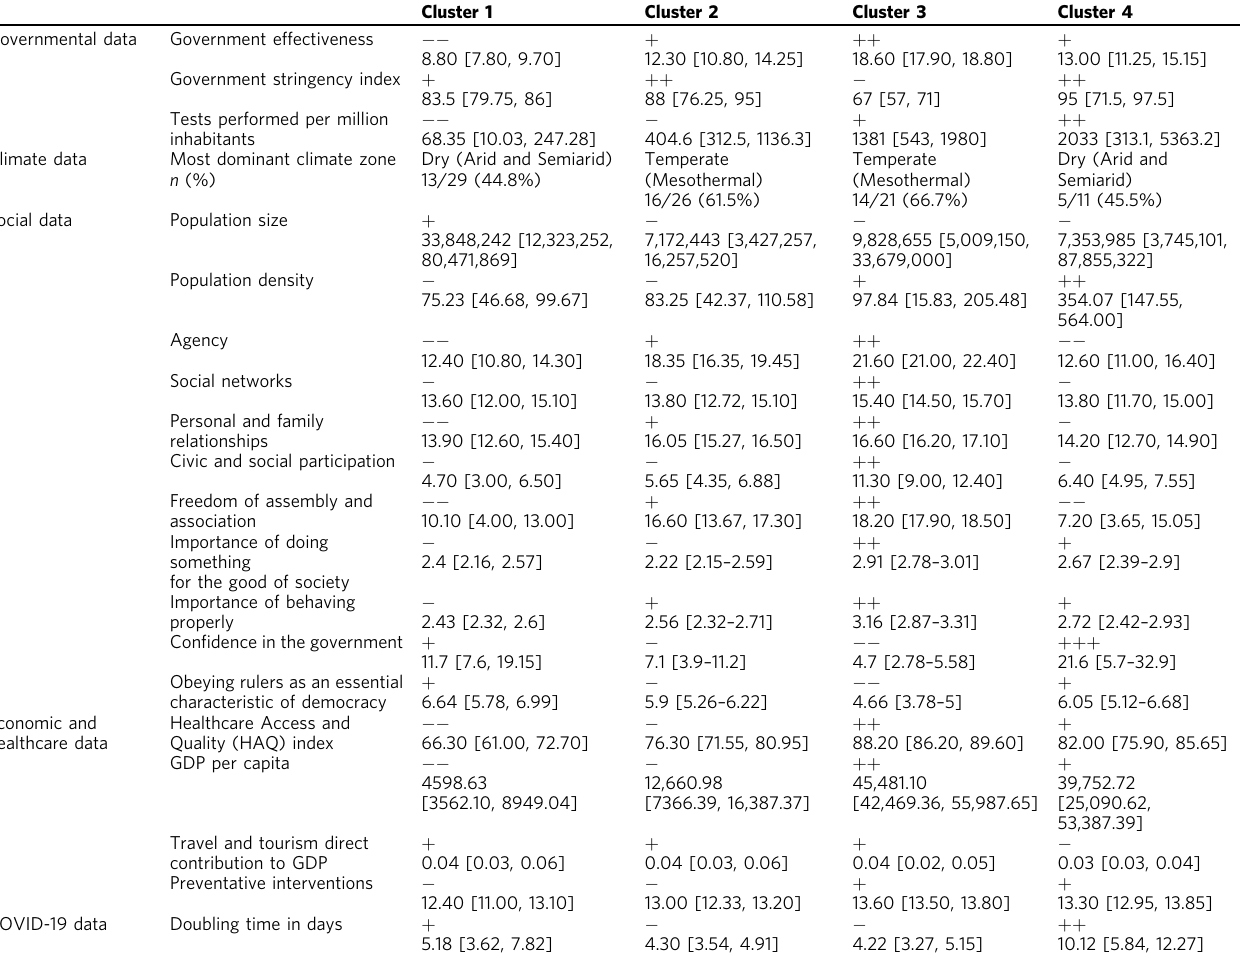
Table 2 Clustering countries with registered COVID-19